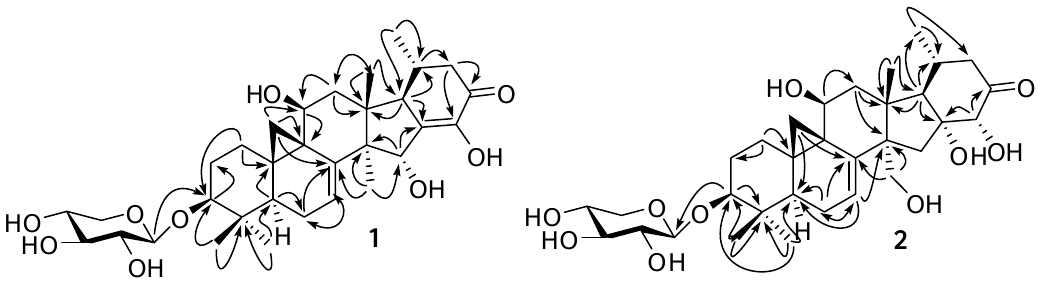
Figure 2. HMBC correlations of compounds 1 and